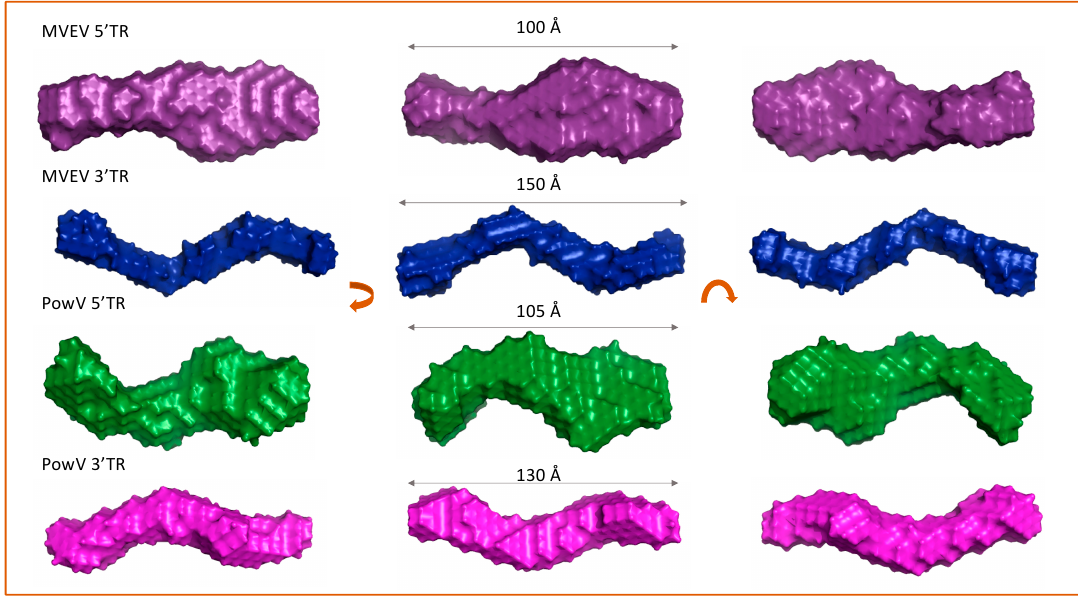
Figure 4. Determination of low-resolution structures using SAXS, which indicates that all RNA molecules adopt an extended structure in solution. For each terminal region RNA, the left and right panels represent 180º rotated view on the x-axis and y-axis, respective of the view presented in the middle panel. Dimensions represent the D max . Table 1. Biophysical parameters of MVEV and PowV non-coding RNAs.